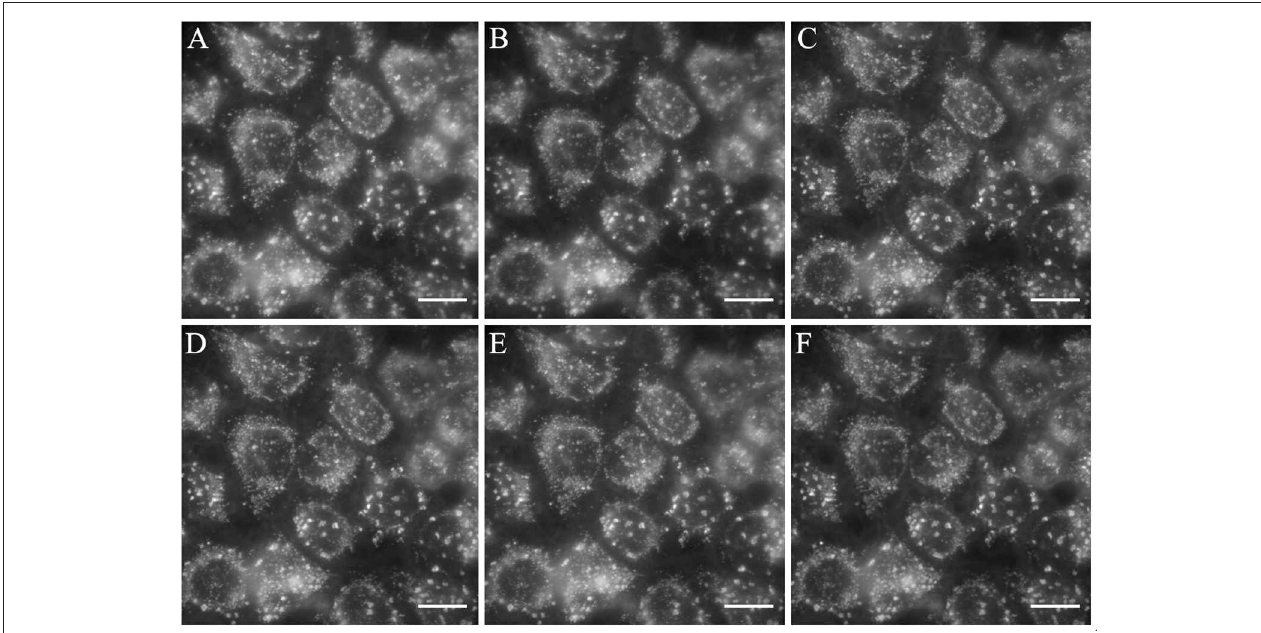
FIGURE 6 | B2 exhibits resistance to photobleaching. HeLa cells were stained with 50 µ g/mL B2 for 30min at 37 ◦ C and observed under the fluorescent microscope immediately (A) , or 5min (B) , 10min (C) , 15min (D) , 30min (E) , 60min (F) after the staining protocol in continuous exposure to the exciting light. We obtained similar results with MCF-7 cells (data not shown). Blinking was not observed (see Supplementary Video 1 ). White bar represents 10 µ m.